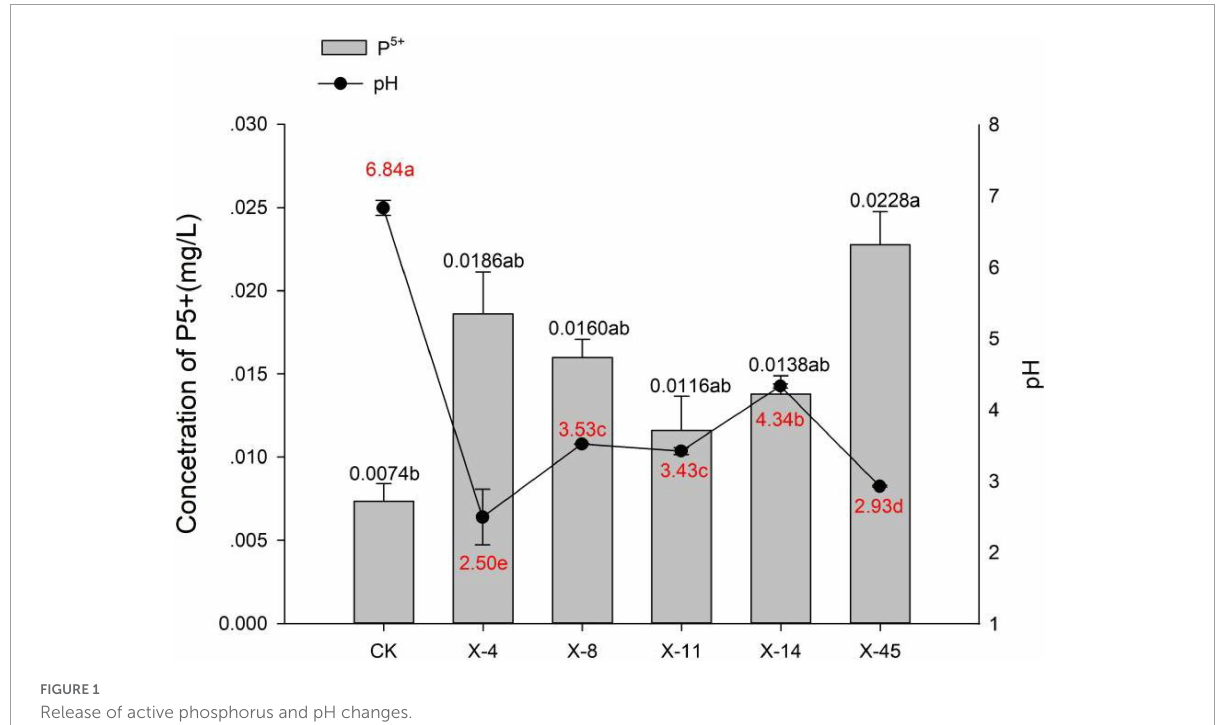
FIGURE1 Release of active phosphorus and pH changes.